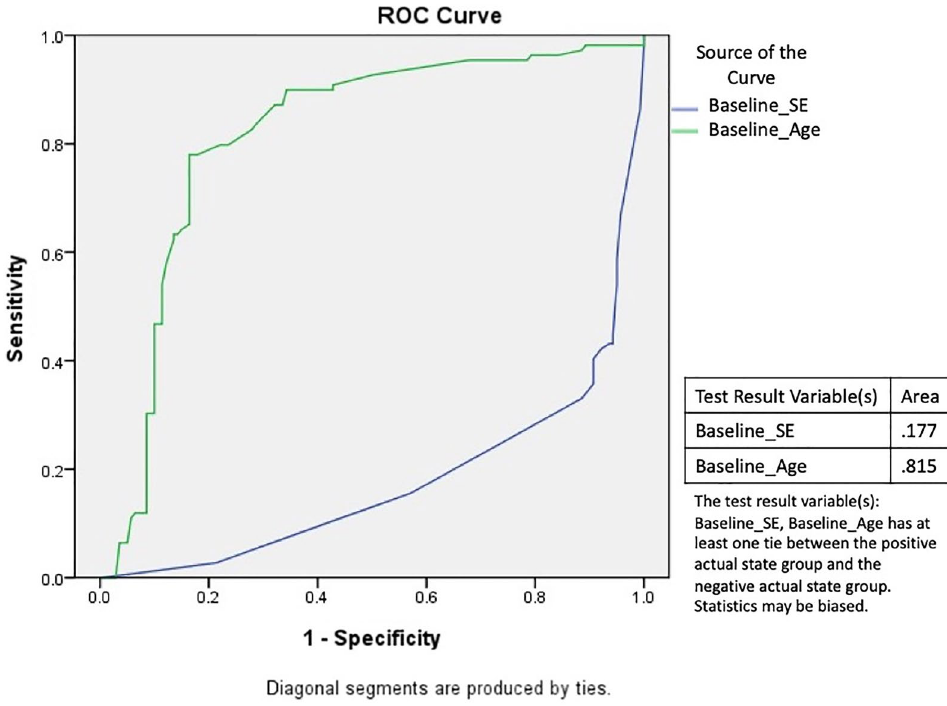
Figure 1. Receiver operating characteristic (ROC) curve analysis of the treatment results based on the baseline spherical equivalent (SE) and baseline age. The cut-off point of the baseline SE was − 1.25 D and that of the baseline age was 8.9 years to achieve the best treatment